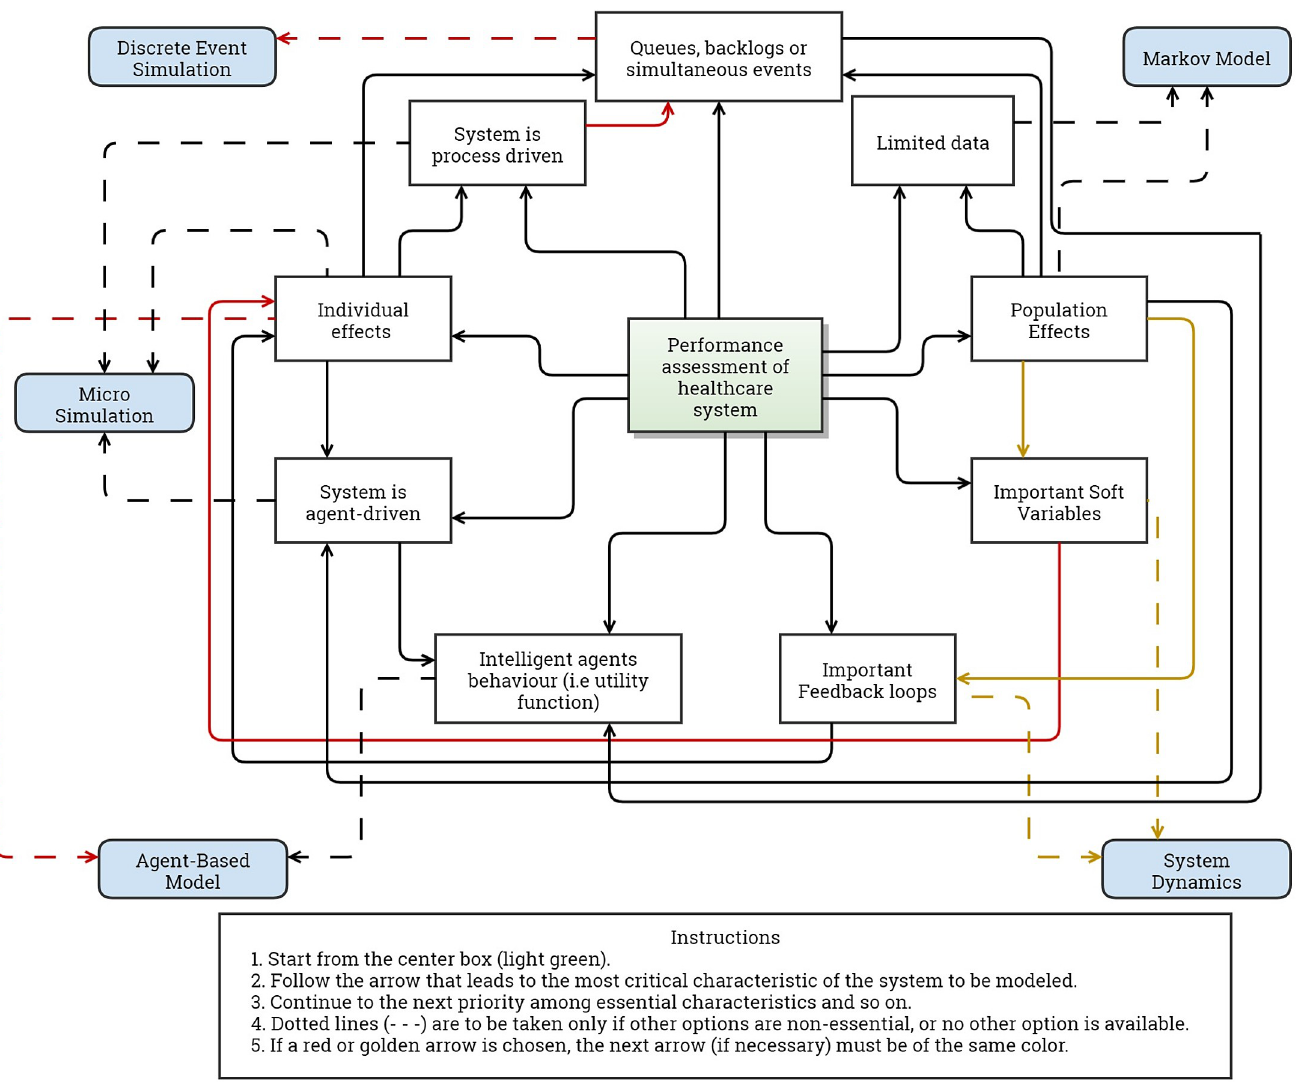
Fig 2. Visual aid to select simulation modeling